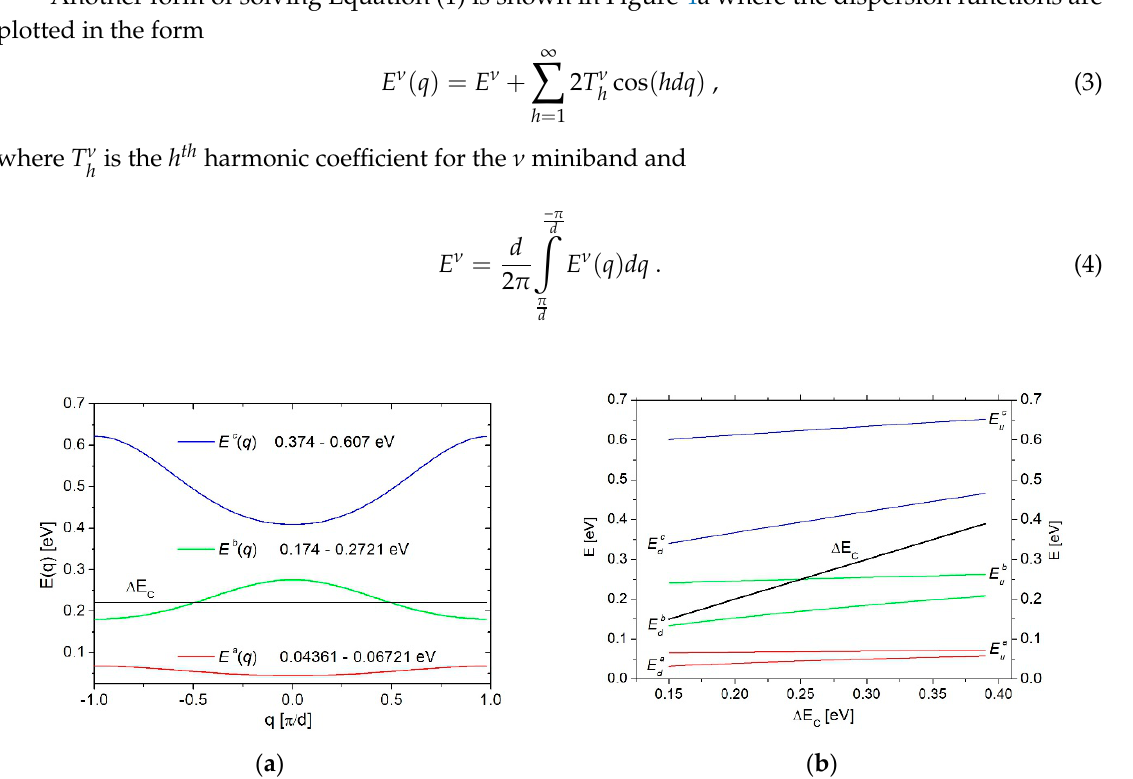
Figure 3. The module (in red) and the phase (in blue) of the selected Bloch state for the energy of the seventh miniband bottom, in turn, labelled g ( E = 190 meV) in the structure no. 3. described in [3].